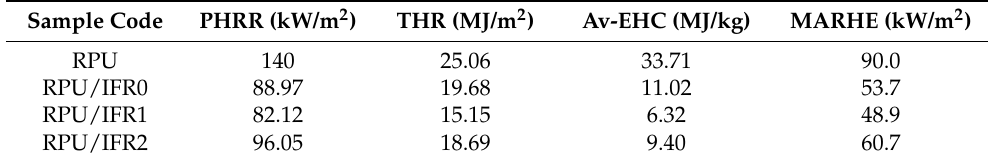
Figure 3. Cone calorimeter curves of neat RPU, RPU/IFR0, RPU/IFR1, and RPU/IFR2 foam samples: ( a ) PHRR and ( b ) THR. Table 3. The cone calorimeter test results for different RPU